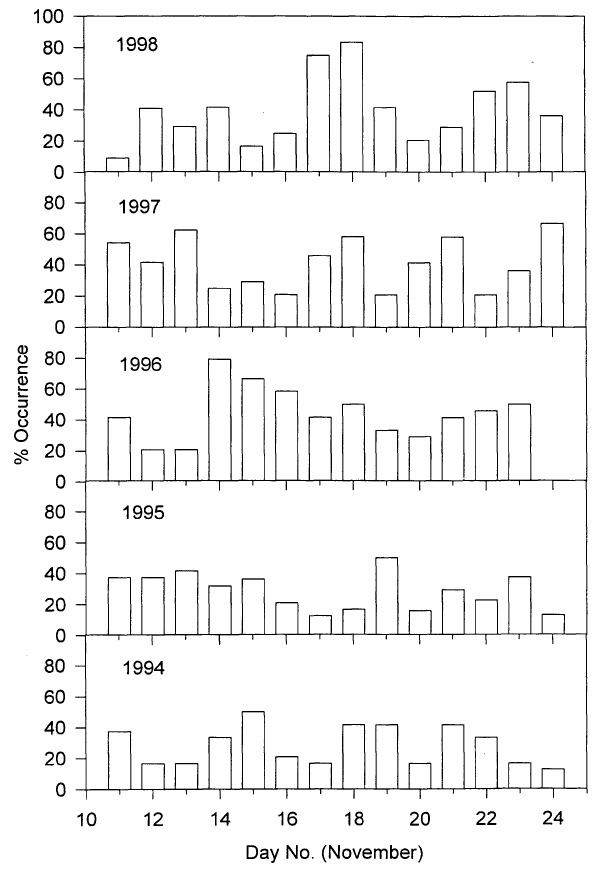
Fig. 1. Daily mean percentage occurrence of sporadic-E over Ahmedabad for the days 11–24, November of years 1994–1998 based on hourly data.